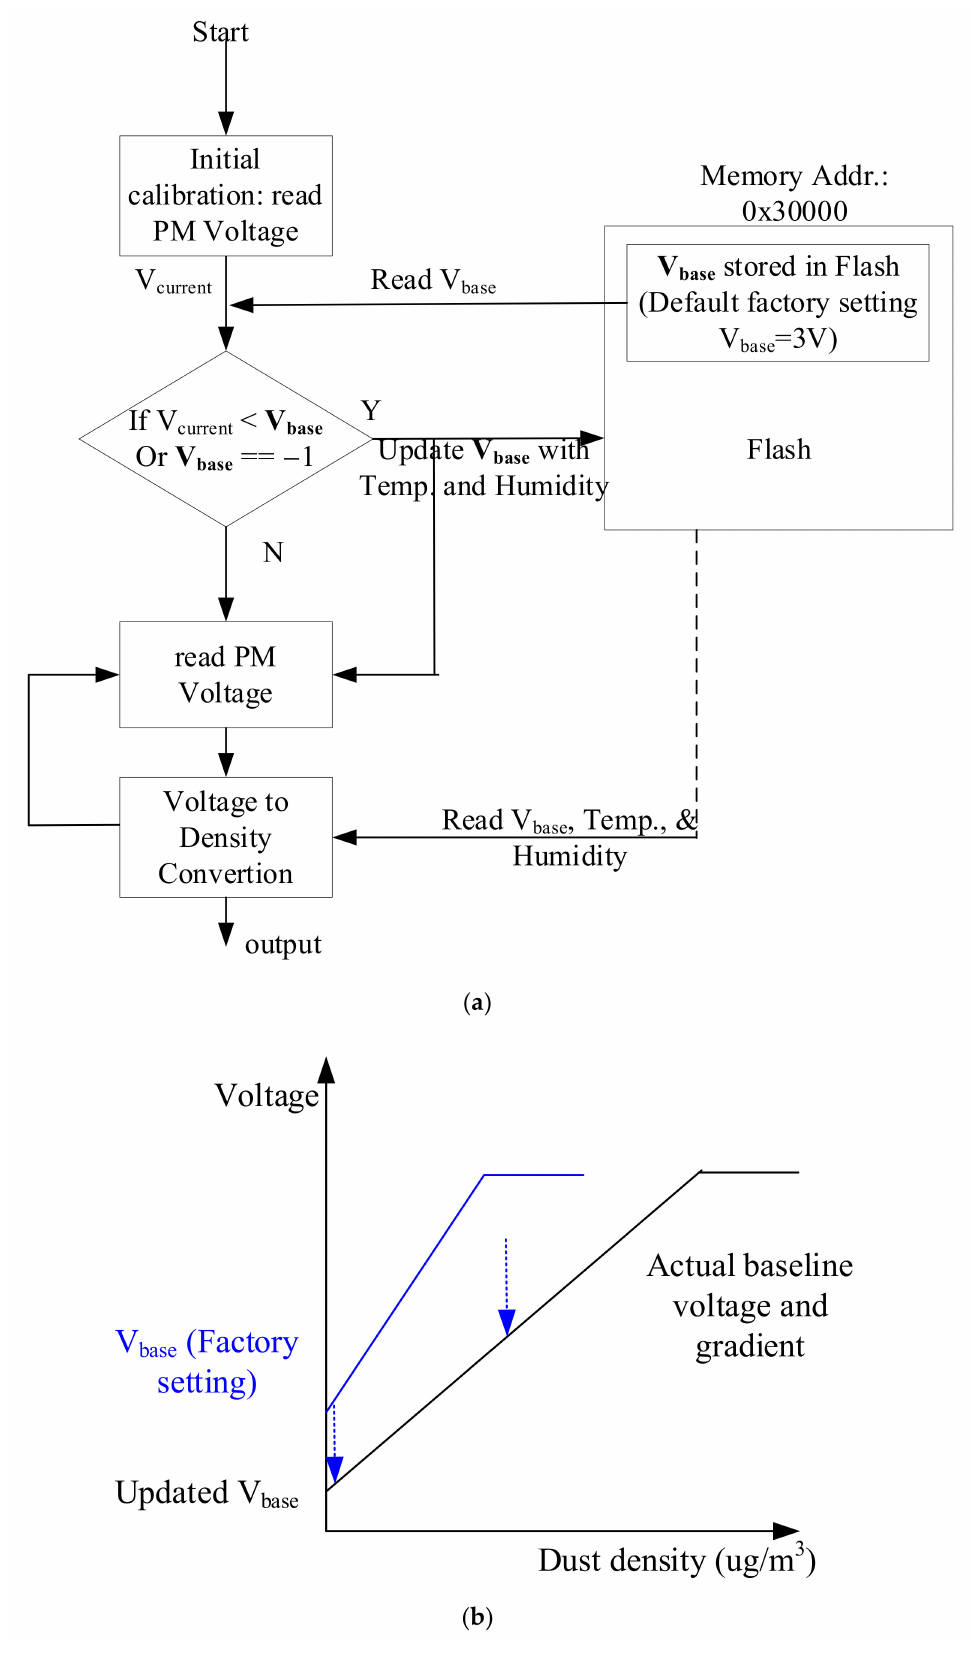
Figure 7. Baseline voltage calibration procedure: ( a ) procedure and ( b )